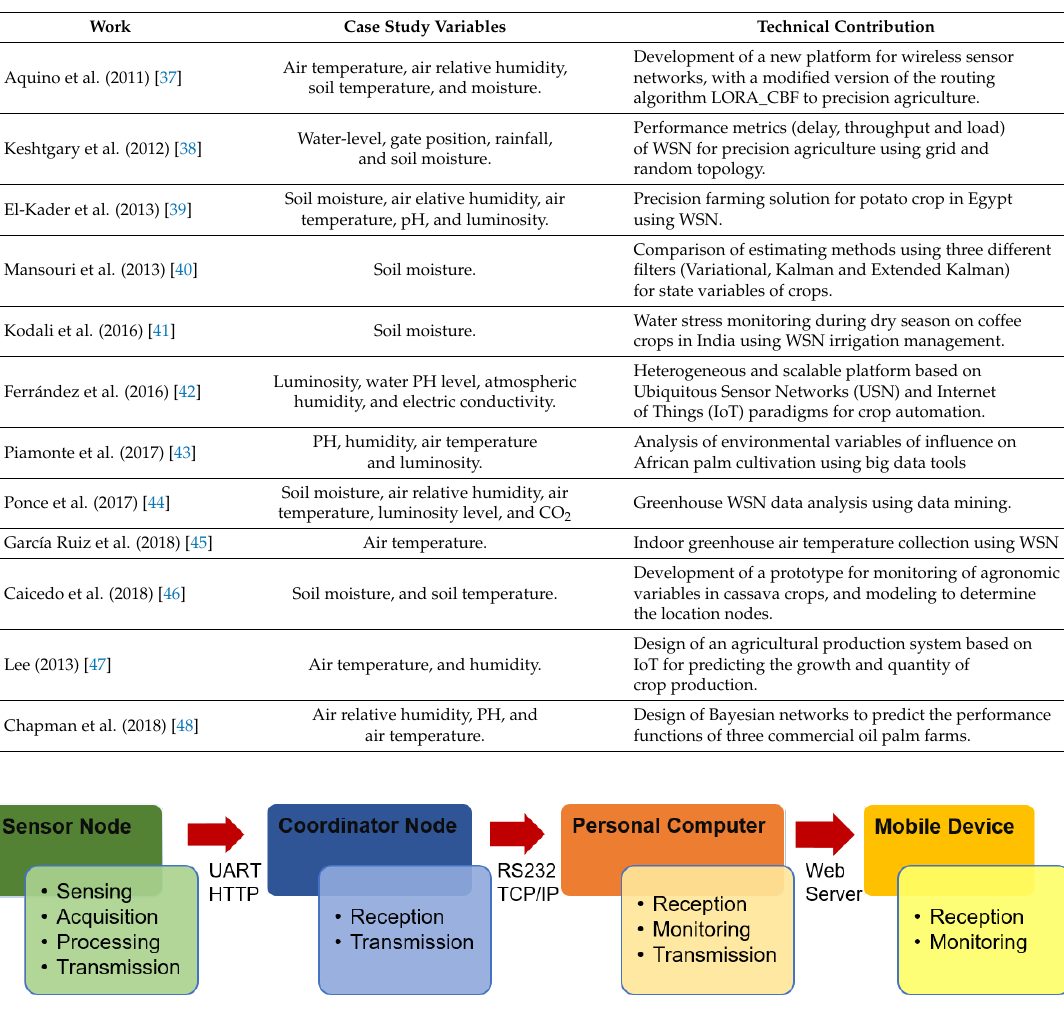
Figure 1. General description of the elements, processes, and communication protocols for the WSN systems in this